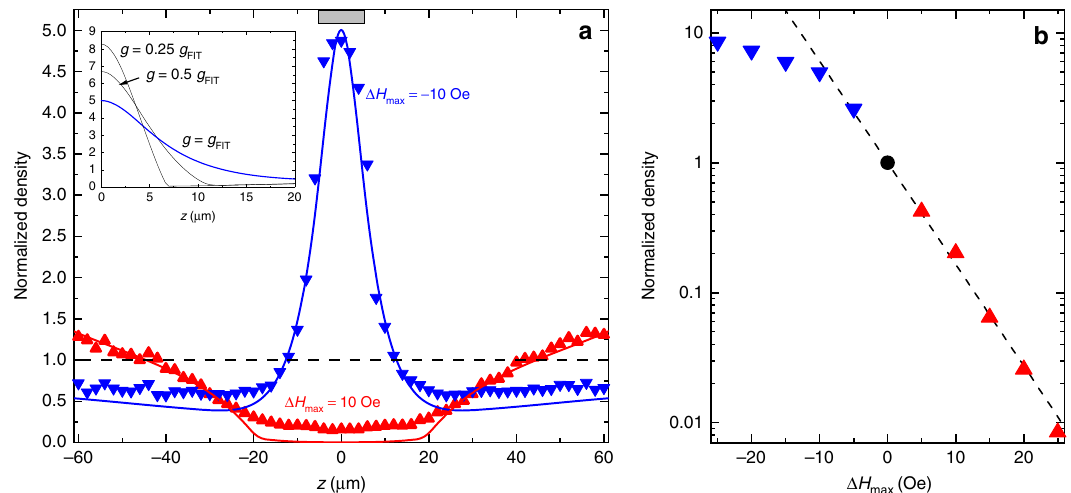
Fig. 2 Spatial redistribution of the condensate density caused by a potential well and a hill. a Representative pro fi les of the condensate density recorded by BLS for the case of a potential well (blue symbols) and a potential hill (red symbols) with the depth/height of 10 Oe. The shown pro fi les are normalized by the value of the density measured in the absence of the potential. The gray rectangle in the upper part marks the position of the control line creating the inhomogeneous fi eld potential. Solid curves show the results obtained from numerical solution of Eq. (8). Inset: Spatial pro fi les of the condensate density calculated for different magnitudes of the coef fi cient g describing the nonlinear magnon – magnon interaction with all other parameters fi xed. The curve labeled g = g FIT is the same, as that in the main fi gure. b Normalized condensate density at the center of the hill/well versus Δ H max in the log-linear scale (the color coding is the same as in a ). The dashed line is the exponential fi t of the data for Δ H max >